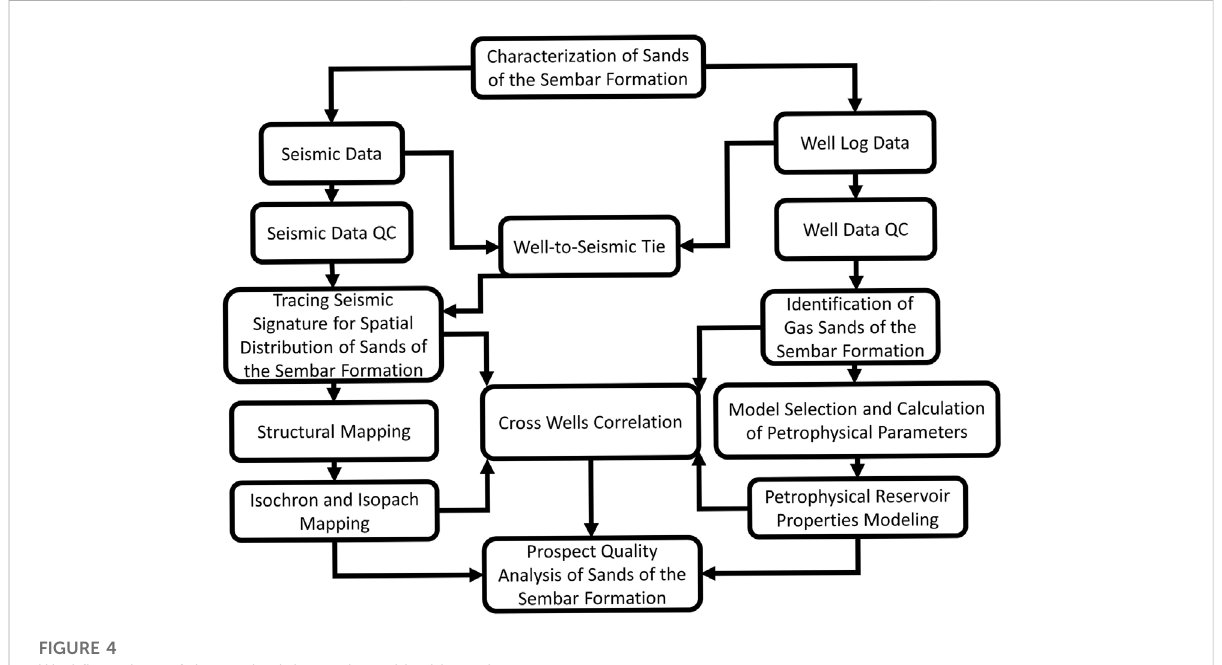
FIGURE 4 Work fl ow chart of the methodology adopted in this